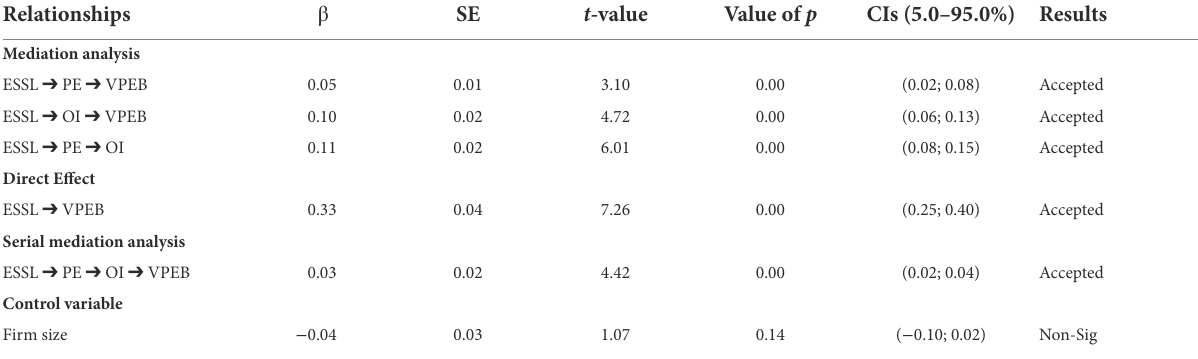
TABLE 4 Hypotheses